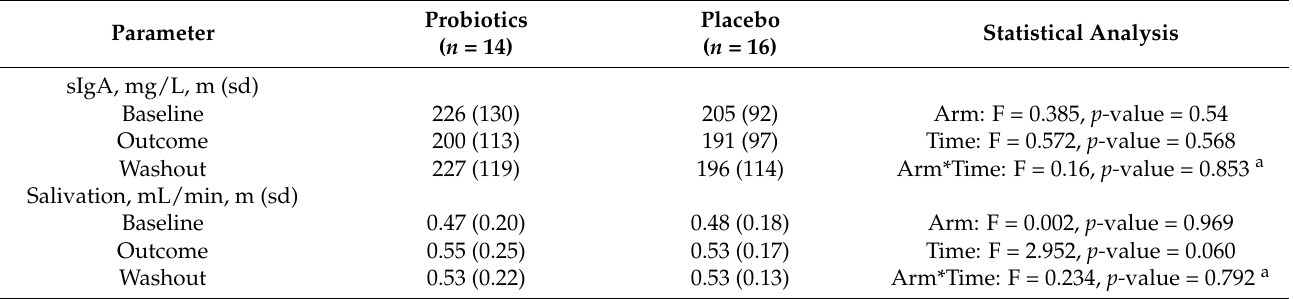
Table 4. Summary of evaluated